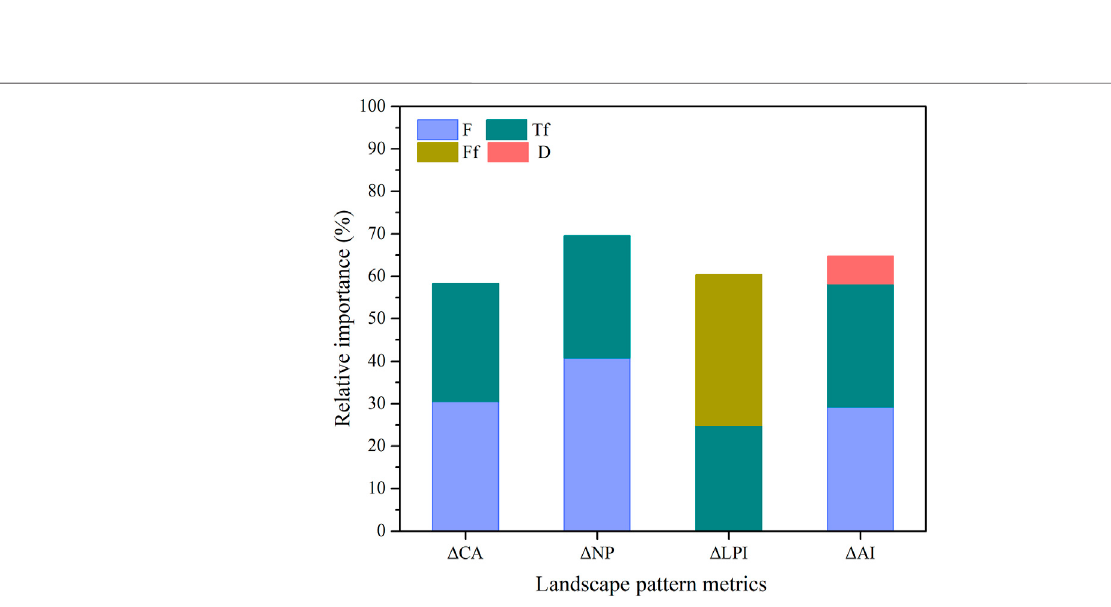
Frontiers in Environmental Science |